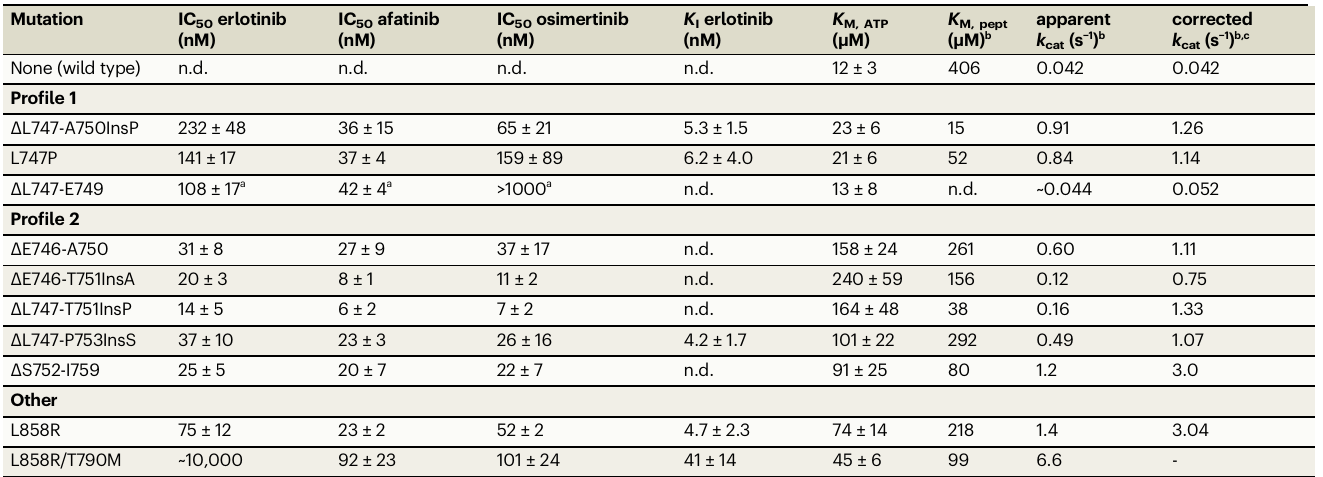
Table 1 | Biochemical properties of EGFR TKDs with different mutations